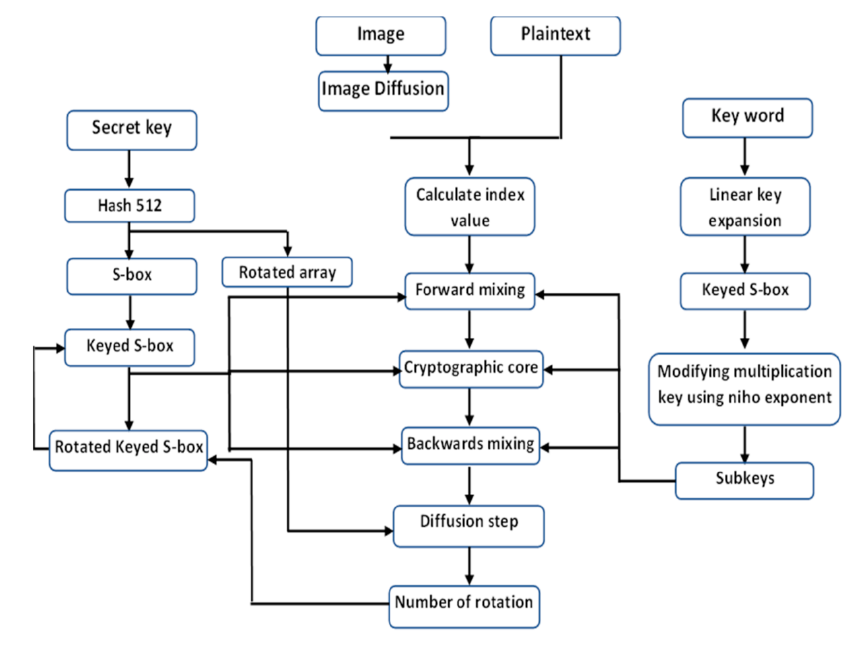
Figure 4. The flow chart of the proposed encryption